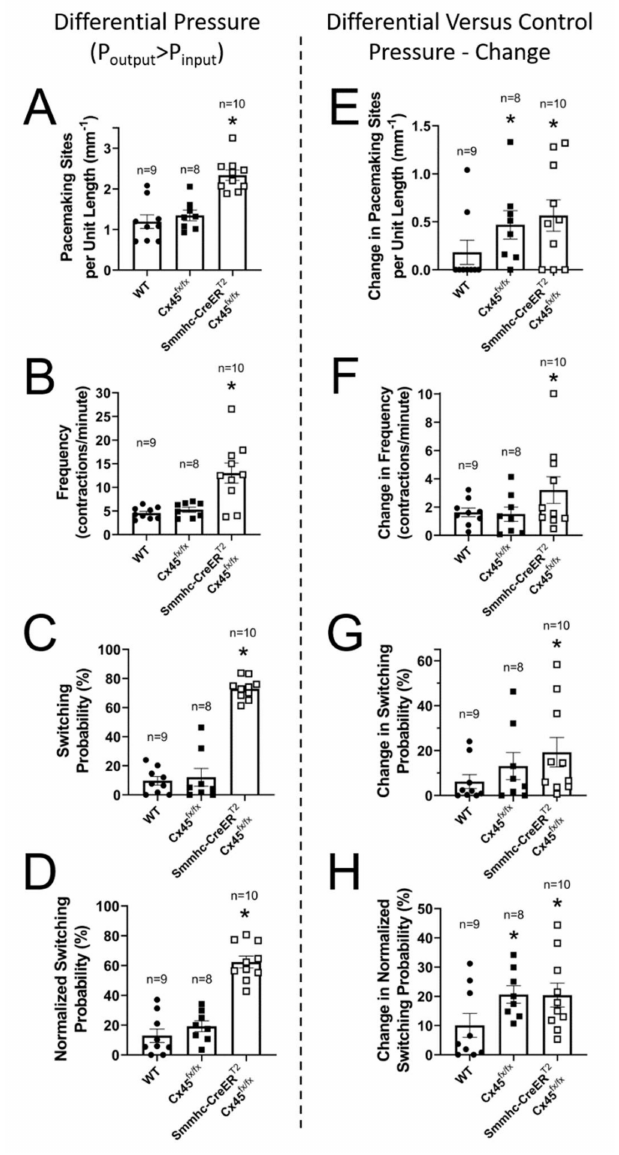
Figure 8. Summary analysis of the pacemaking activity in lymphatic vessels from control (C57BL / 6J WT and Cx45 fx / fx ) and LMC Cx45-deficient (Smmhc-CreER T2 ;Cx45 fx / fx ) mice under di ff erentially increased downstream intraluminal pressure (P downstream > P upstream ): ( A ) Number of pacemaking sites per unit length; ( B ) Pacemaking frequency (frequency of contractions); ( C ) Calculated switching probability; ( D ) Calculated normalized switching probability; ( E – H ) Change in number of pacemaking sites per unit length, change in frequency, change in percent switching probability, and change in normalized switching probability for pacemaking parameters calculated as the di ff erence in pacemaking parameters measured under di ff erential pressure conditions versus control pressures (equal upstream and downstream pressures set at 2 cmH 2 O). * Indicates statistical significance ( p < 0.05) when compared to all other unmarked